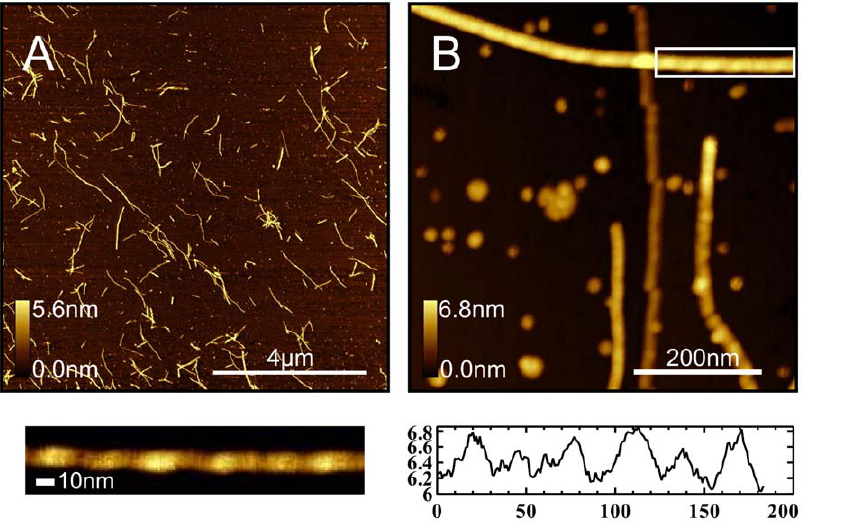
Figure 6. AFM topography images of A b (1–42) incubated in solution (500 m g/mL concentration) at 37 6 C for 22 hours. After incubation, 10 m L of solution was deposited onto cleaved mica for 5 minutes, followed by rinsing with nanopure water and drying with a gentle nitrogen stream. A 10 6 10 m m scan area (A) of the surface shows many fibrils ranging from 0.1 – 4 m m. (B) High resolution image (500 6 500nm) demonstrates that fibrils reveal twisted morphologies, characteristic of formed in solution; (below, left) expanded view of region enclosed by white box in (B) with optimized z-scale; (below, right) height profile along fibril axis clearly demonstrating maxima and minima which is characteristic of the twisted